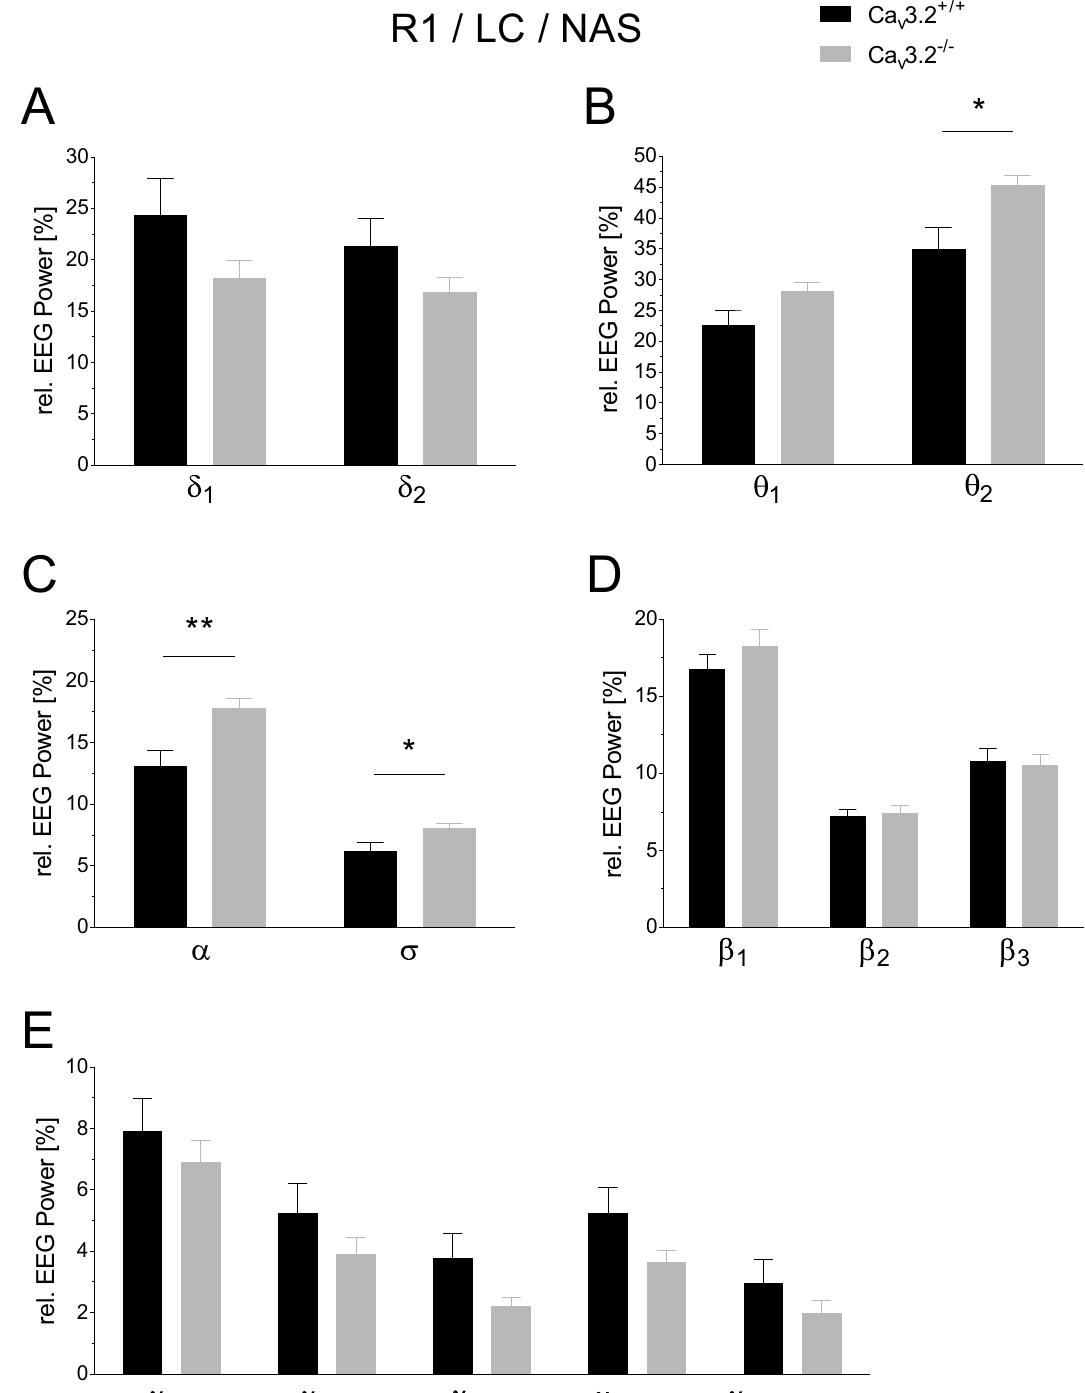
Figure 5. EEG power analysis during the non-active light cycle state (24 h long-term recording R1) in Ca v 3.2 +/+ and Ca v 3.2 −/− mice. Relative EEG power (%) for both genotypes is displayed for the individual frequency ranges ( A–E ). Significant alterations were observed for the θ 2 , α and σ frequency ranges ( B , C ). Changes in relative theta/theta-alpha power in Ca v 3.2 −/− mice during the NAS point to functional alterations in type II theta